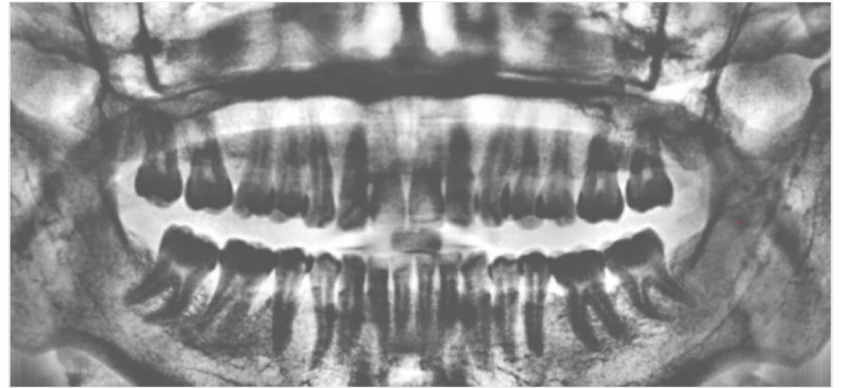
Figure 15. Transformation of the pixel